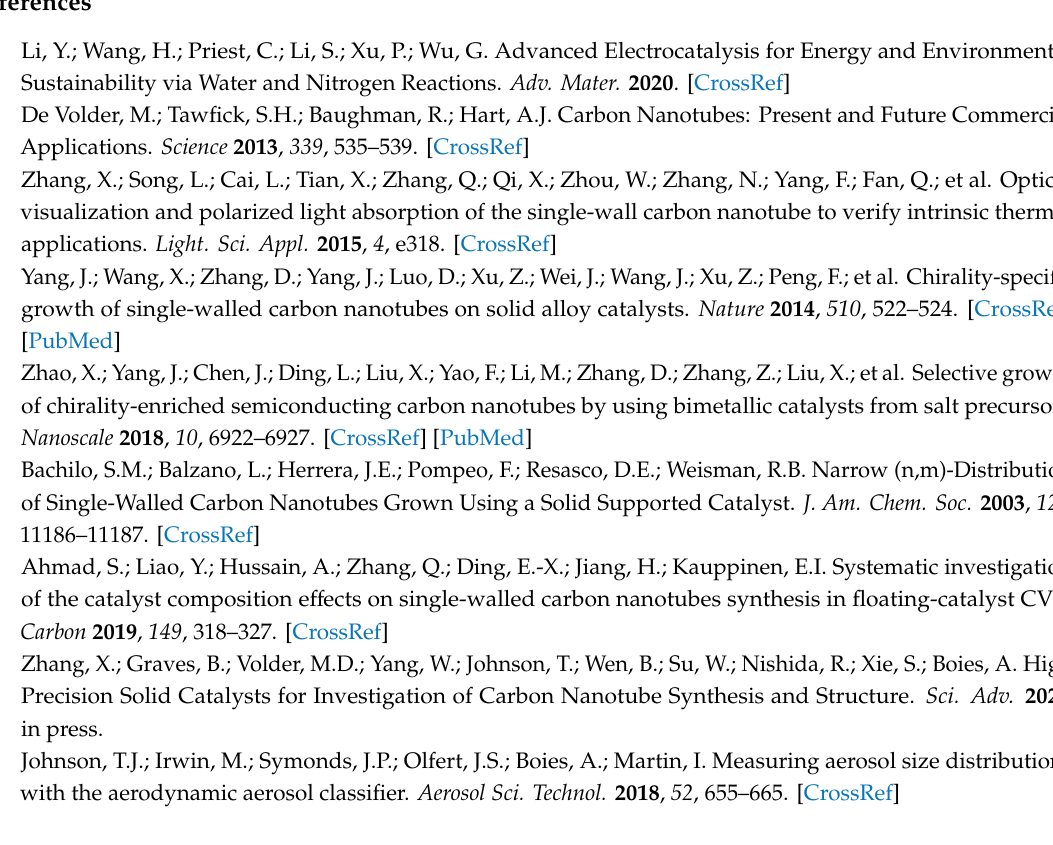
Table S1: Interplanar spacings statistics of alloyed mNPs measured from HRTEM, Table S2: Interplanar